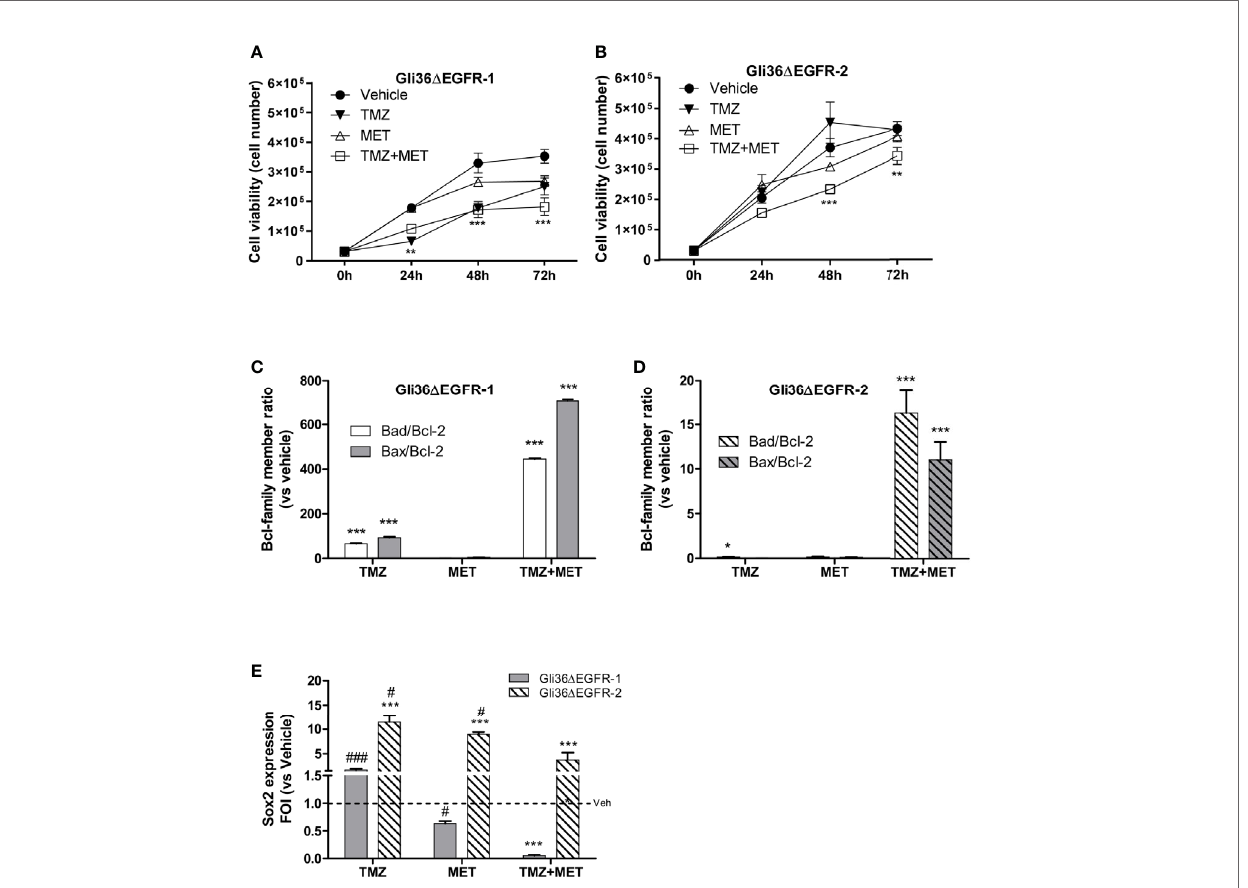
FIGURE 1 | In vitro treatment ef fi cacy. Evaluation of time-response viability of TMZ-sensitive (A) and – resistant (B) cells after vehicle, TMZ, MET or TMZ+MET treatment. Cell viability was assessed by means of a Trypan blue exclusion test and expressed as the number of viable cells after 24, 48 or 72 h of treatment. Two- way ANOVA analysis followed by Bonferroni ’ s multiple comparisons test was performed, **p < 0.01, ***p < 0.001 vs vehicle-treated cells. The induction of pro- apoptotic ( bad and bax ) and anti-apoptotic genes ( bcl-2 ) was analyzed by means of real-time PCR in glioma Gli36 D EGFR-1 (C) and Gli36 D EGFR-2 (D) cells treated with TMZ, MET or the combination and expressed as bax/bcl-2 or bad/bcl-2 ratio. One-way ANOVA analysis followed by Tukey ’ s multiple comparison test was performed, *p < 0.05, **p < 0.01, ***p < 0.001. (E) , TMZ+MET treatment decreased sox2 expression measured using q-real-time PCR in Gli36 D EGFR-1 cells and counteracted its increase in Gli36 D EGFR-2 cells. One-way ANOVA analysis followed by Tukey ’ s multiple comparison test was performed, ***p < 0.001 vs vehicle- treated cells; # p < 0.05, ### p < 0.001 vs TMZ+MET treatment. The molecular data were normalized to b -actin, and the DD ct values were expressed as fold of induction (FOI) of the ratio between treated and control cells. Data were expressed as mean values ± SD of three independent experiments. FOI, fold of induction; MET, metformin; TMZ,